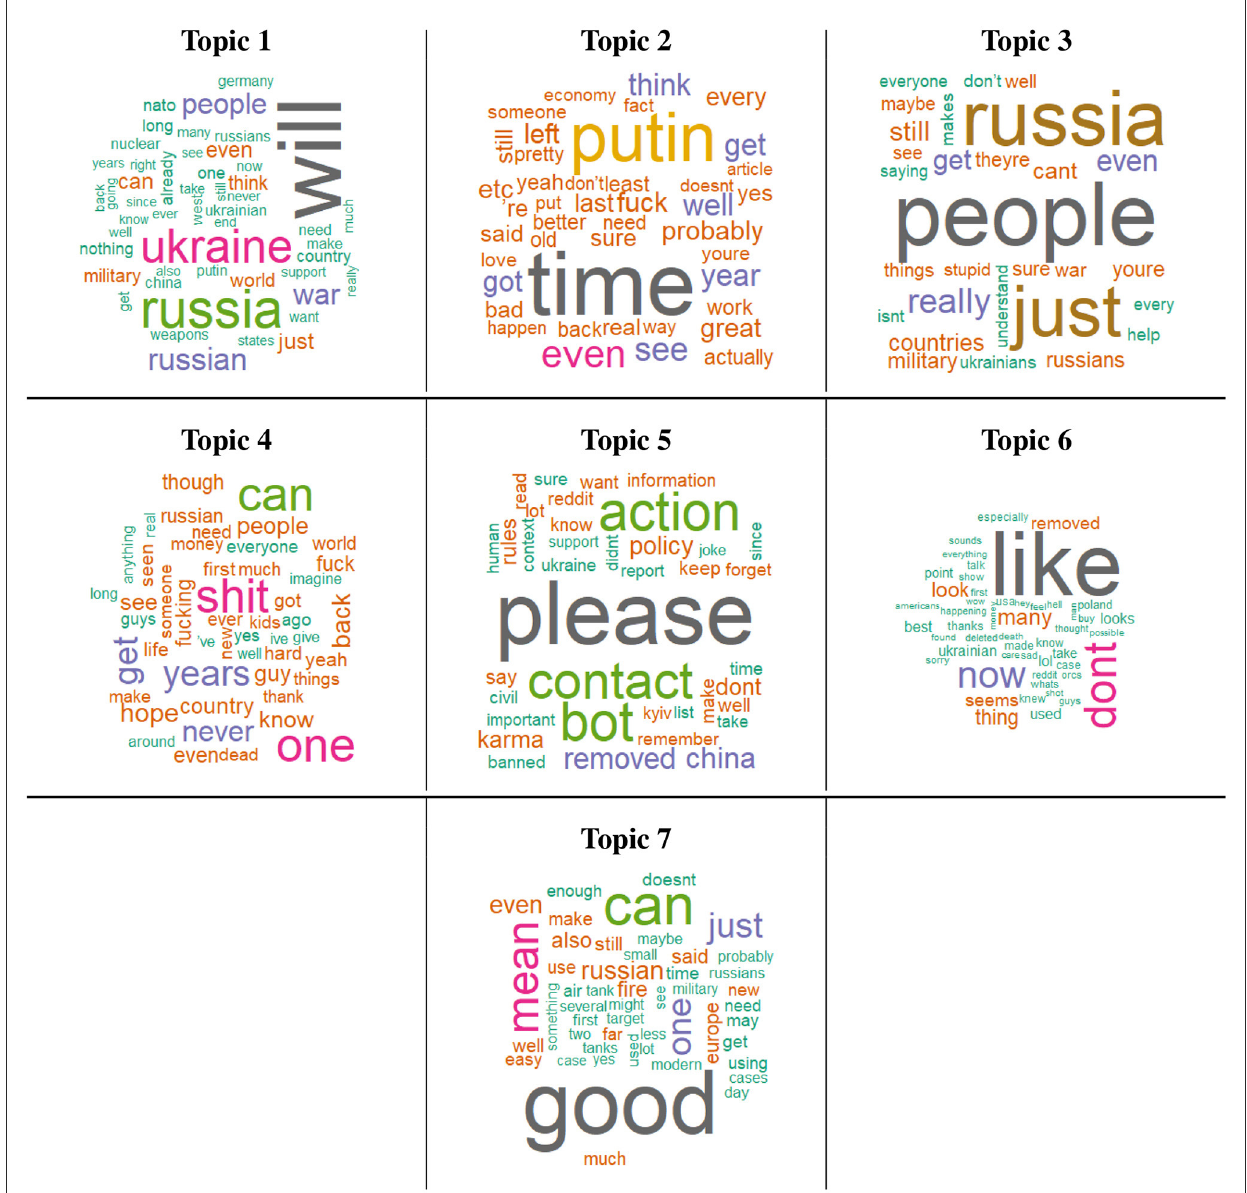
FIGURE8 Wordcloud representation for each topic. Each wordcloud highlights some of the specific words (with different sizes depending on the number of submissions) mentioned by the users in their posts.